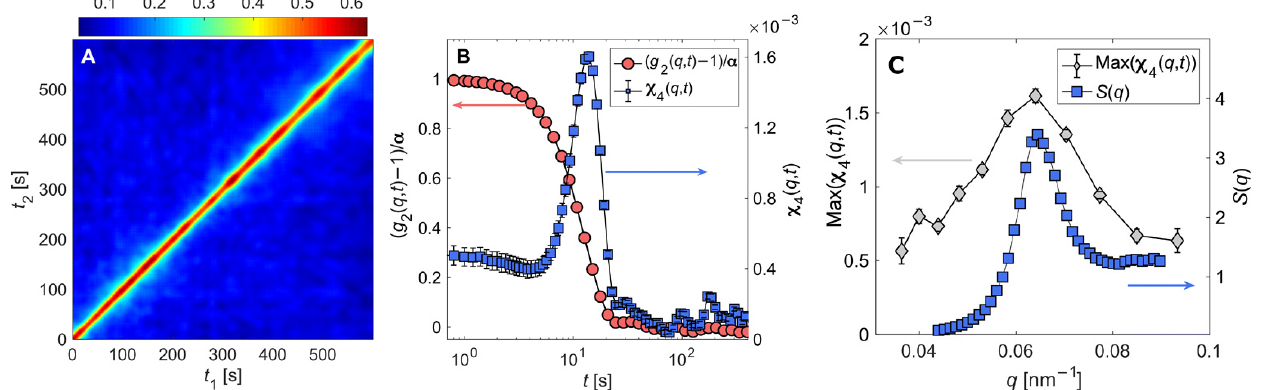
Figure 7. ( A ) Two-time correlation matrix C ( q max , t 1 , t 2 ) computed at the peak of S ( q ) in horizontal direction. Fluctuations are clearly visible as a sign of heterogeneous dynamics. ( B ) χ ( q , t ) (here named χ 4 ) and the corresponding normalized intensity autocorrelation function at q max . ( C ) Peak value of χ ( q , t ) compared to S ( q ) . Both functions show a maximum at q max . Multiplying the maximum of χ ( q , t ) and the total number of particles in the scattering volume an estimate of the number of particles participating in a correlated ballistic motion is found to 10 4 . Figure from [32] reproduced under CC BY-NC